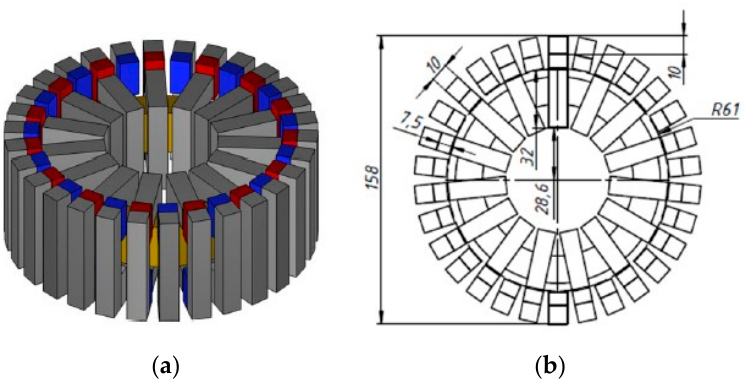
Figure 6. Single-phase TFM with an outer rotor: ( a ) 3D FEM model and ( b ) basic dimensions. To decrease cogging torque of the machine with an external rotor, the configuration of